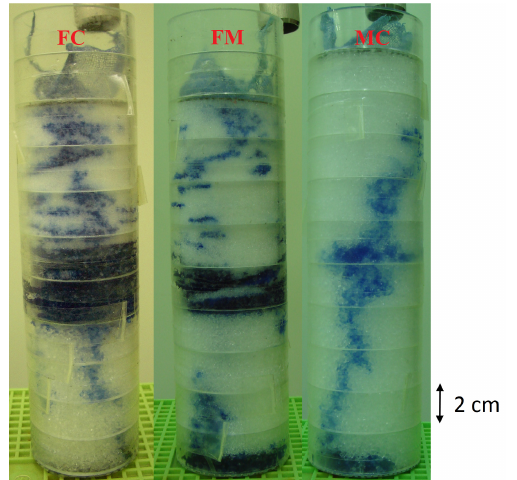
Figure 2. Three samples at the end of the experiments: FC2 (on the left, as an example of FC samples), FM2 (at the center, as an example of FM samples), and MC1 (on the right, as an example of MC samples).